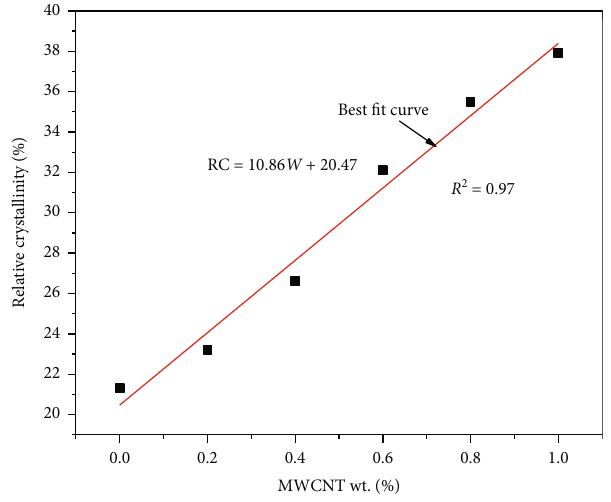
Figure 6: Relative crystallinity of MWCNT nanocomposites.